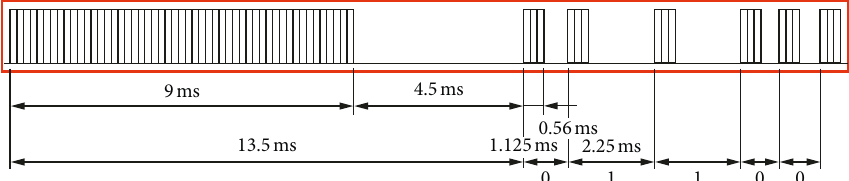
Figure 3: Waveform formats of leader code and logical data of NEC protocol.